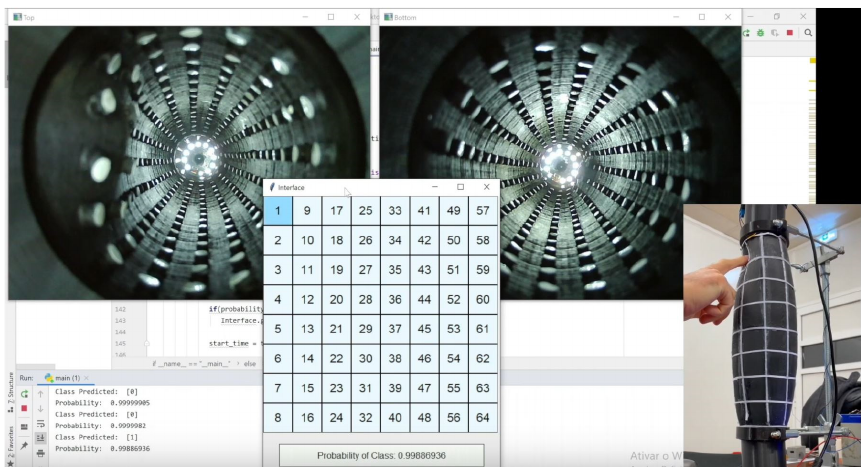
Figure 1. Real ‐ Time classification of the vision sleeve.